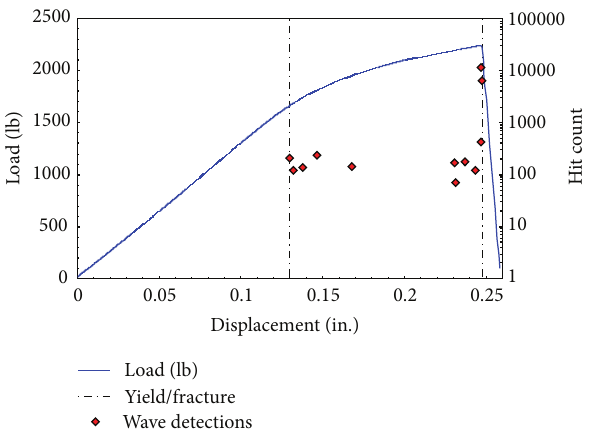
Figure 1: Correlation of the detected strain waves and the load- displacement curve of a uniaxially loaded metal sample with single acoustic emission sensor. Individual points are the energies associated with individual strain waves detected by